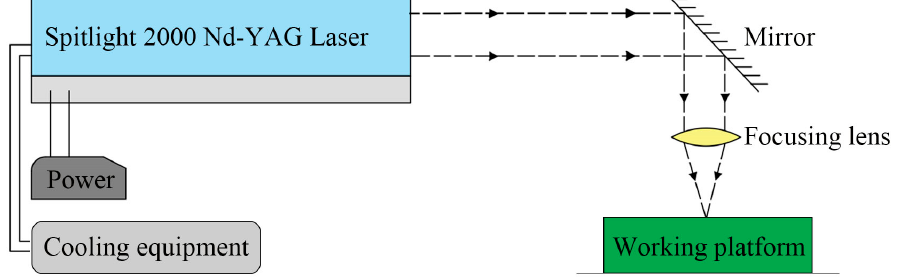
Figure 1. Schematic of the laser machining equipment.